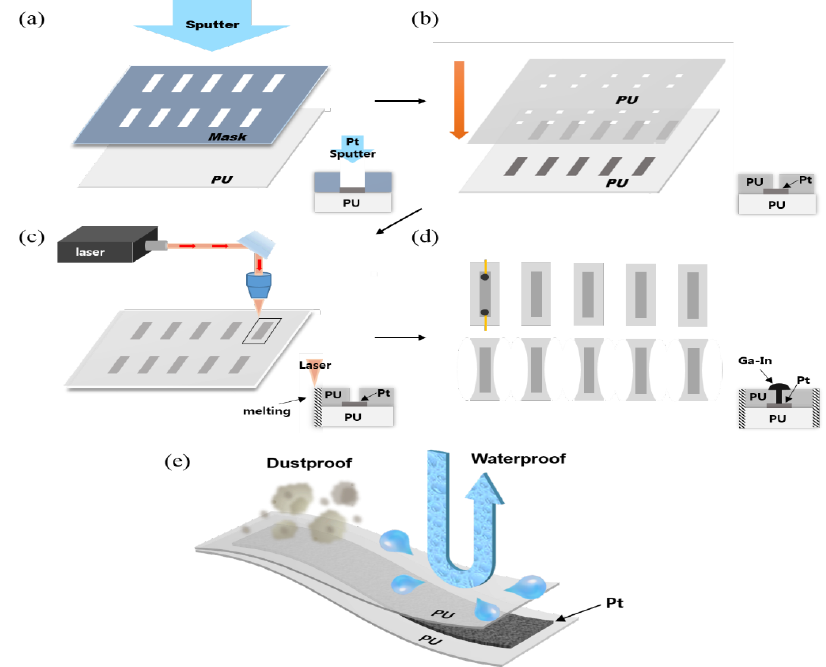
Figure 1. ( a – d ) Schematic of sensor fabrication and encapsulation; ( e ) Testing one-step laser encapsulation (OLE) sensor performance.